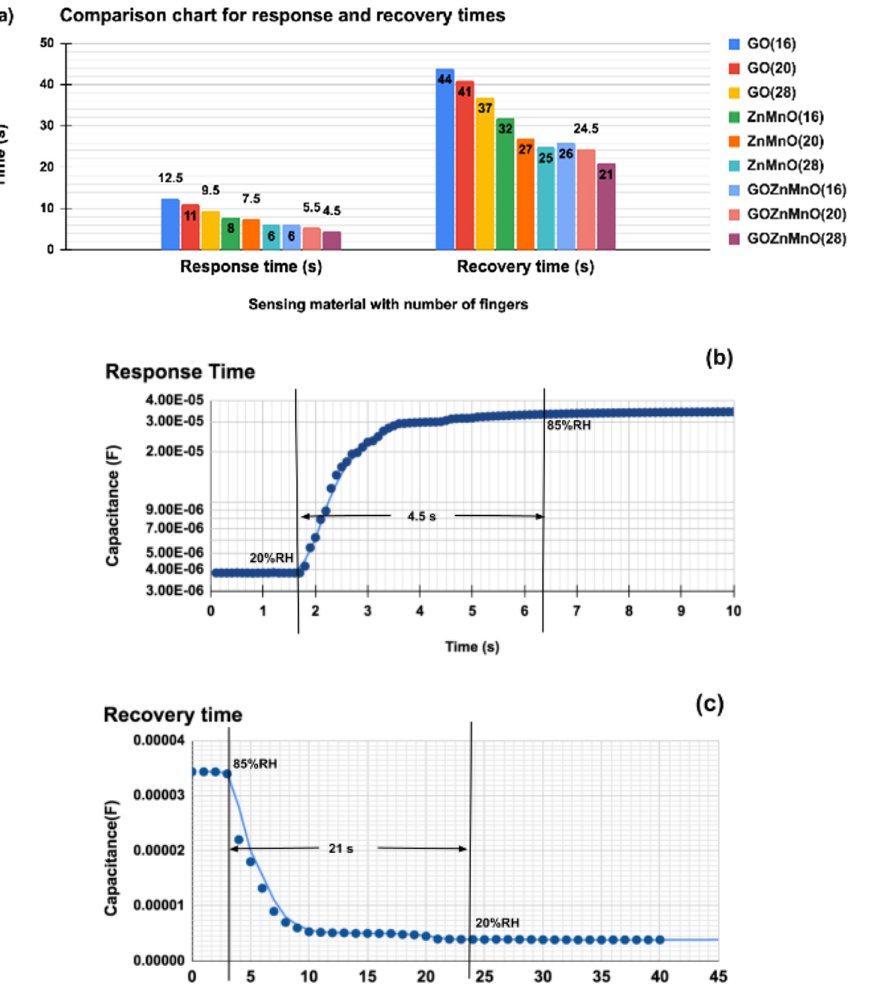
Figure 9. ( a ) Change in impedance with frequency at 50%RH and room temperature of 25 o C for GO-Mn x Zn 1 − x O nanocomposite, ( b ) sensitivity vs. RH% comparison chart for GO-Mn x Zn 1 − x O nanocomposite, Mn x Zn 1 − x O and GO for 28-finger comb electrodes in terms of resistance ( Ω ). ( c ) Defined sensitivity(S R ) as a function of RH% for 28-finger comb electrode in resistance ( Ω ) with a linear fit.